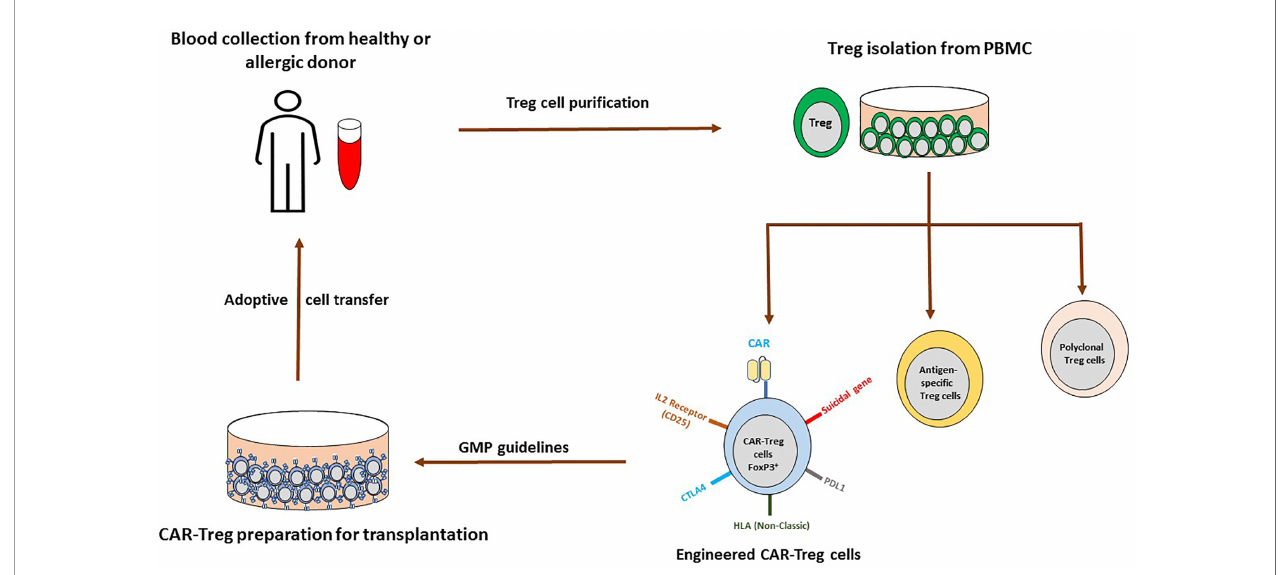
FIGURE 2 | Possible adoptive CAR-Treg cell therapy for allergic asthma. Treg cells are isolated from peripheral blood of healthy and allergic donor, cultured with IL-2 for polyclonal Treg cells (CD3/CD28 beads), antigen-speci fi c cells (antigen presenting cells activate alloreactive Treg cells) and genetically engineered Treg cells. In genetically engineered Treg approach, cells could be transduced with retroviruses, lentiviruses, adenovirus-associated virus (AAV), transcription activator-like effector nucleases (TALEN), Zinc fi nger nucleases (ZFN) or CRISPR-Cas to express CAR, TCR, BAR and others. With this approach immunological rejection would be avoided (introduction of the non- classical HLA and deletion of donor HLA molecules), in case of off target, suicidal gene system could be activated and co-expression of others such as PDL1, CTLA4, and IL- 2R would help in the speci fi c migration, suppression and inactivation of T cells. Further, following GMP regulations, expanded cells could be infused in the